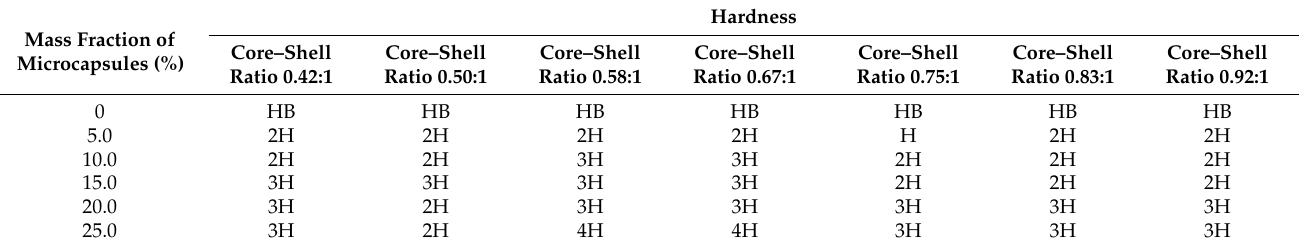
Table 3. The hardness of the coatings.